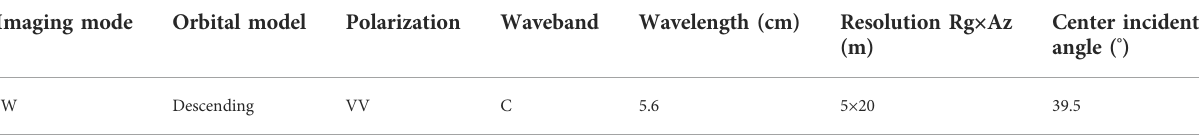
TABLE 1 Sentinel-1A Remote sensing image data